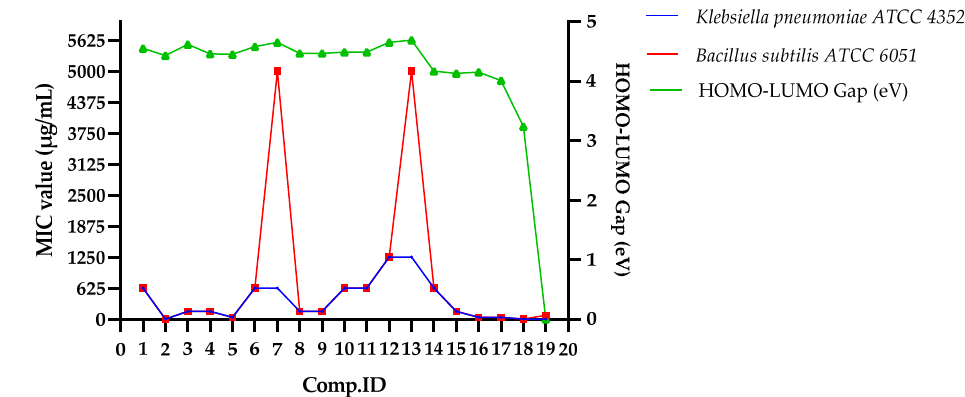
Figure 6. The results of the quantitative assay of the antimicrobial activity of tested compounds 1 – 18 as (SM-IMP-01) to SM-IMP-13), and (DA-01-05), respectively. Wherein, 19 was used as a standard drug, ciprofloxacin, and the corresponding MIC value (µg/mL).